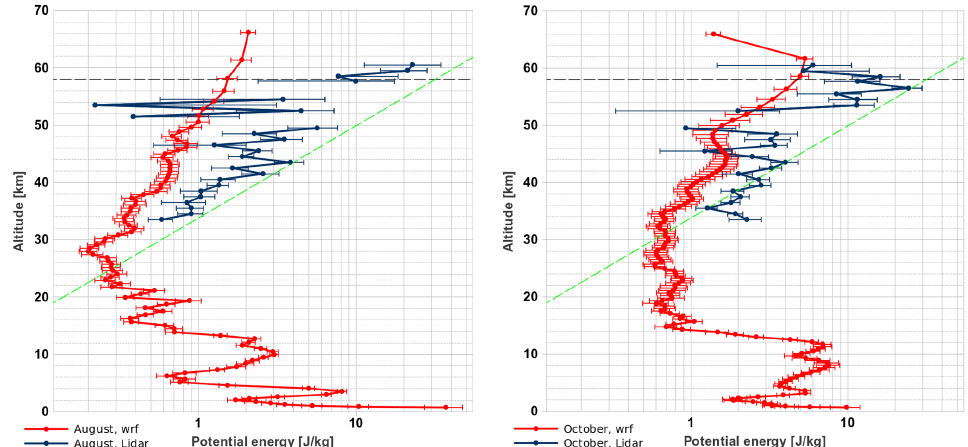
Figure 11. Vertical profiles of potential energy per unit mass (Jkg − 1 ) derived from WRF model (red line) and lidar observations (blue line) in semi-log scale ( x axis). Left panel: August averaged profiles. Right panel: October averaged profiles. The conservative growth rate curve is also superimposed (green dashed line) with a constant density scale height H ∼ 7km. Horizontal error bars indicate the ± 1 σ temporal uncertainty of the mean. Horizontal black line identifies the altitude of sponge layer, at 58km.